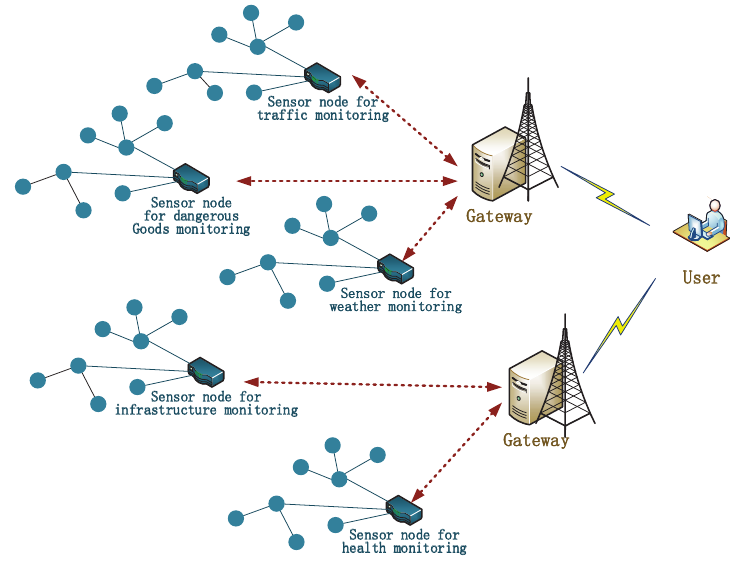
Figure 1. WSNs system